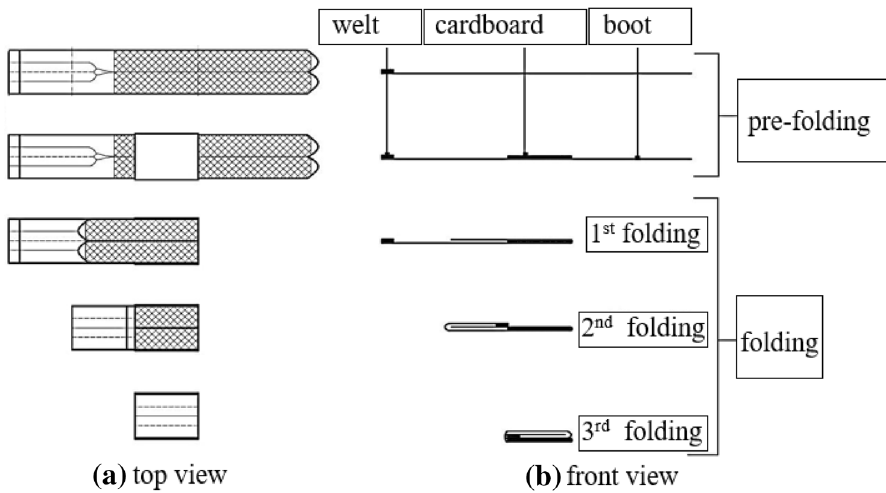
Fig. 1 Folding process of pantyhose